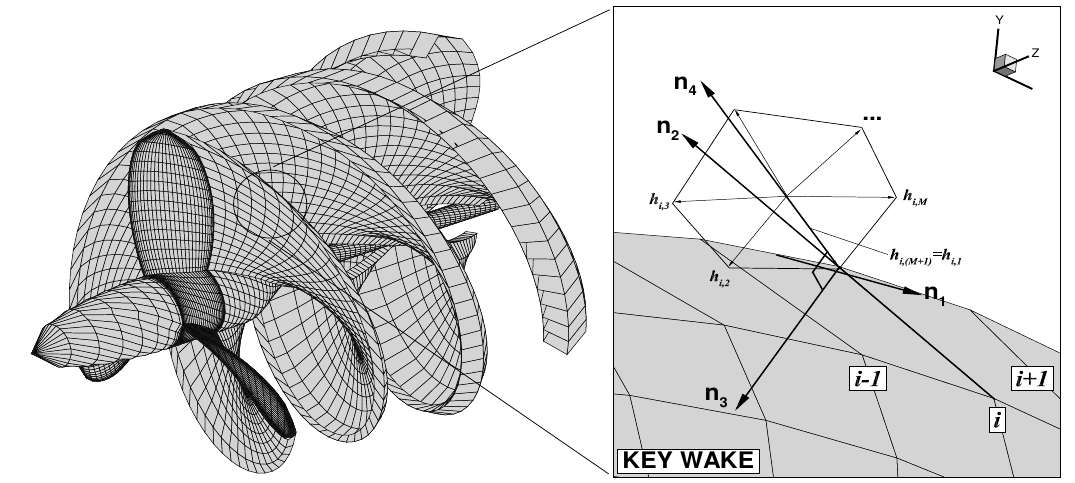
Figure 5. Schematics of tip vortex paneling at each section of the wake tip. Panel nodes are placed clockwise direction when viewed from